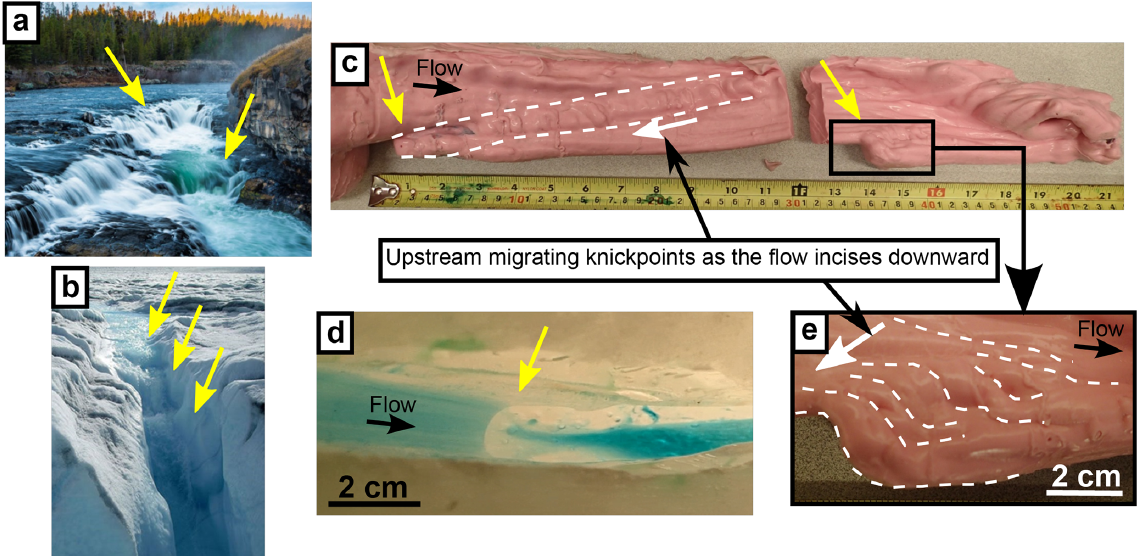
Figure 9. Knickpoints indicated by yellow arrows on (a) mixed bedrock alluvial river, (b) supraglacial meltwater channel, (c) rubber mold of a laboratory meltwater channel, (d) laboratory meltwater channel and (e) close-up of rubber mold shown in (c) . Image information: (a) Sheep Falls at Falls River, ID; source: Josh Packer. (b) Supraglacial meltwater channel flowing towards a moulin on the Greenland ice sheet; source: Jim Kastengren. (c–e) Source: this study. Table 1. Statistics of planform parameters. Channel type Sinuosity (cid:127) [–] / Wavelength-to-width ratio λ/B [–] Fatness Skewness Min. q 1 Median q